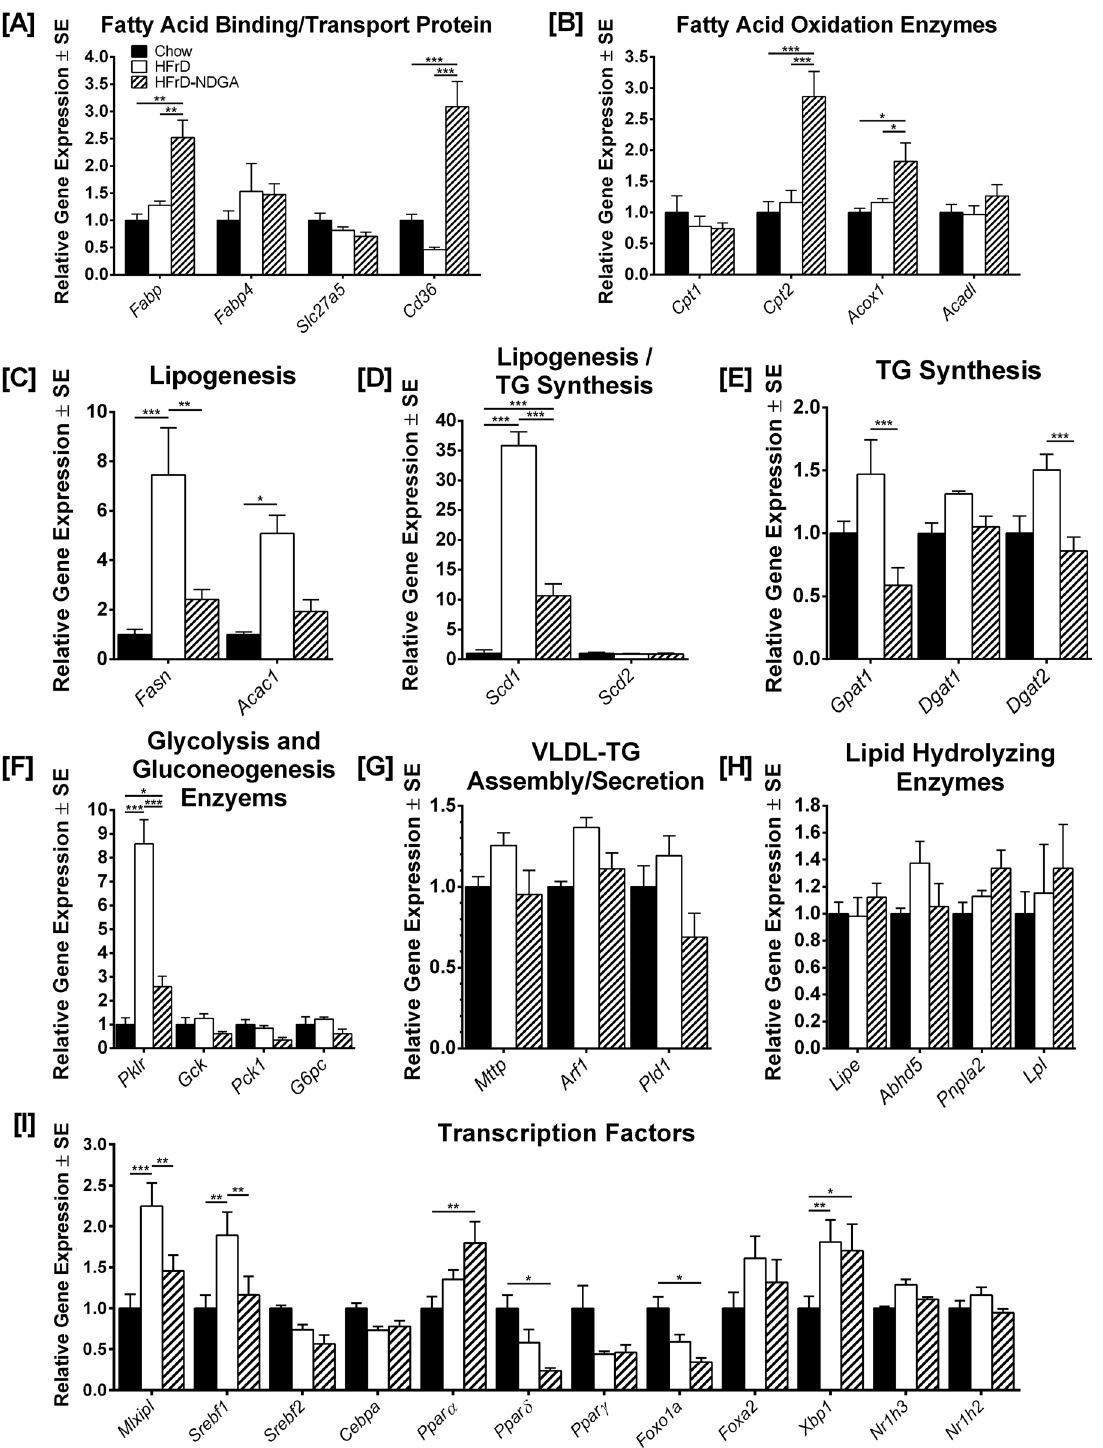
Fig 3. Effect of acute NDGA treatment on the expression of genes and transcription factors involved in hepatic fatty acid metabolism and development of hepatic steatosis in high-fructose diet (HFrD) fed hypertriglyceridemic rats. Quantitative RT-PCR of RNA from livers of chow-fed rats, rats fed an HFrD for 8 weeks and rats fed an HFrD for 8 weeks and subsequently treated with NDGA at a dose of 125 mg/kg BW twice a day by oral gavage. Results are mean ± SE of 3 independent RT-PCR experiments for each gene with 6 rats within each group. Data are presented relative to 36B4 in the same samples, and relative mRNA levels were determined by qRT-PCR using the comparative C T method. * P < 0.05; ** P < 0 . 01; *** P < 0 . 001 . Raw data and statistics are listed in S1 Dataset.